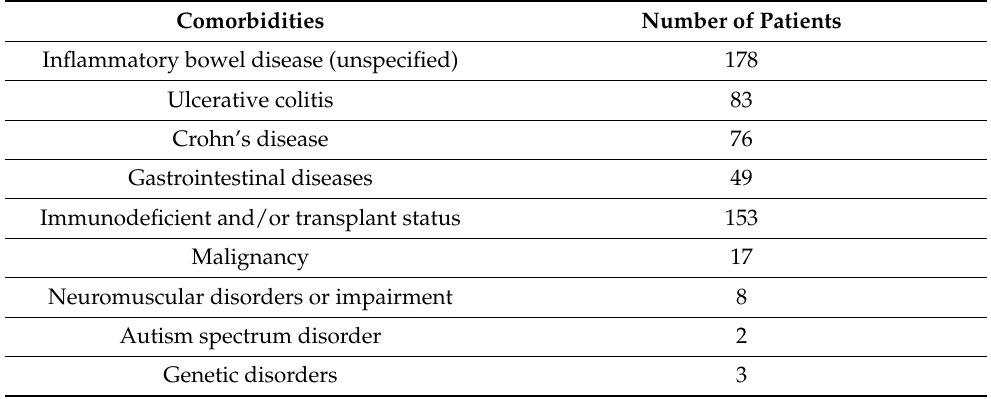
Table 3. Comorbidities found among the patients included in the systematic review and meta-analysis.